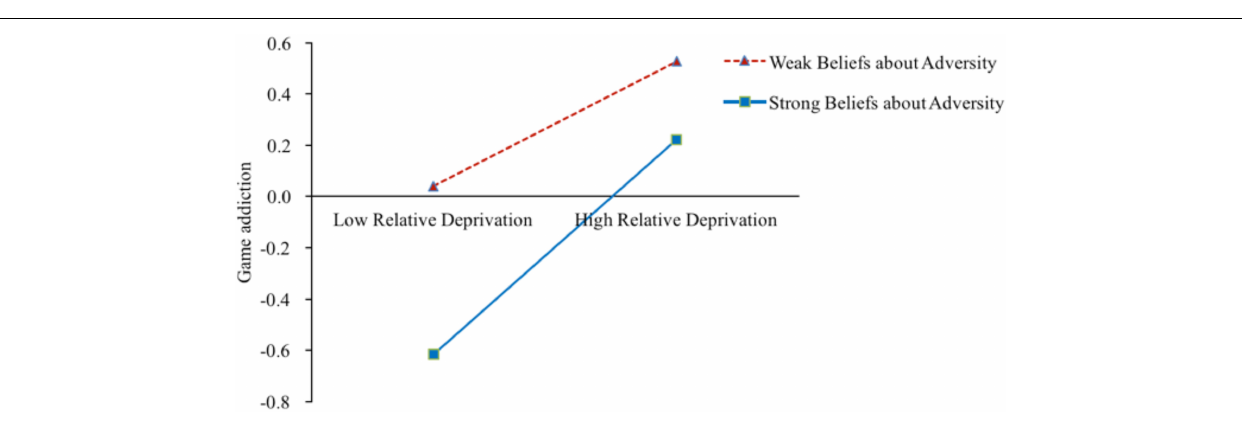
attitudes of deviant peers (Laible et al., 2016; Wang et al.,